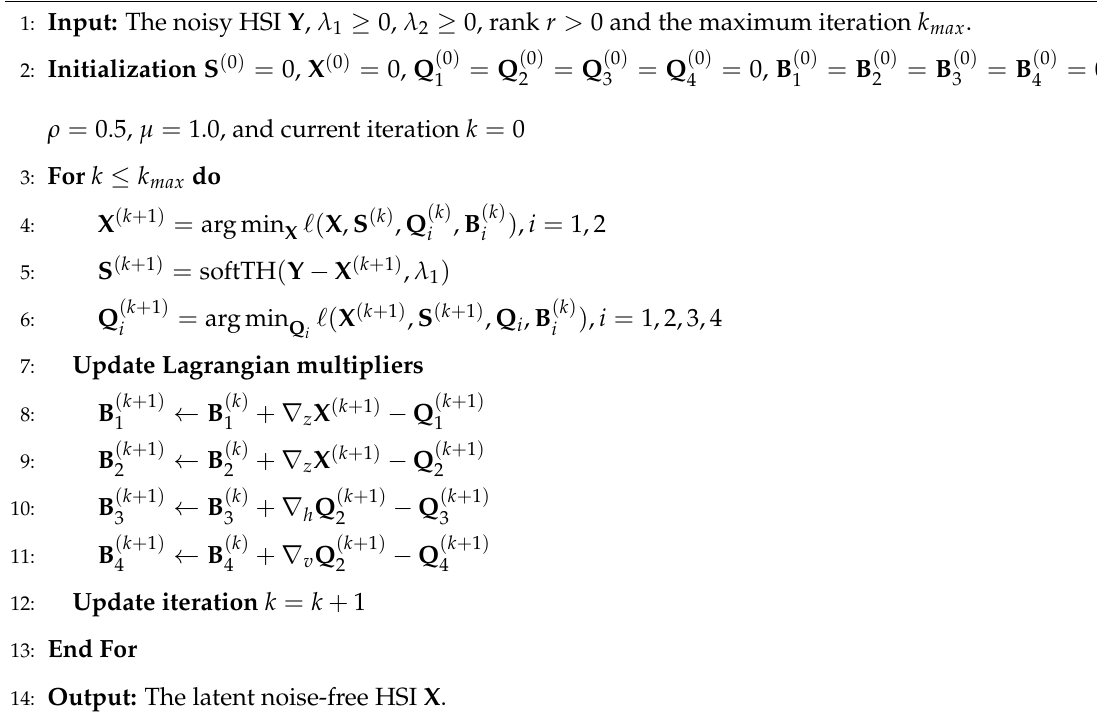
Algorithm 1 The pseudo-code for SDTVLA solver via